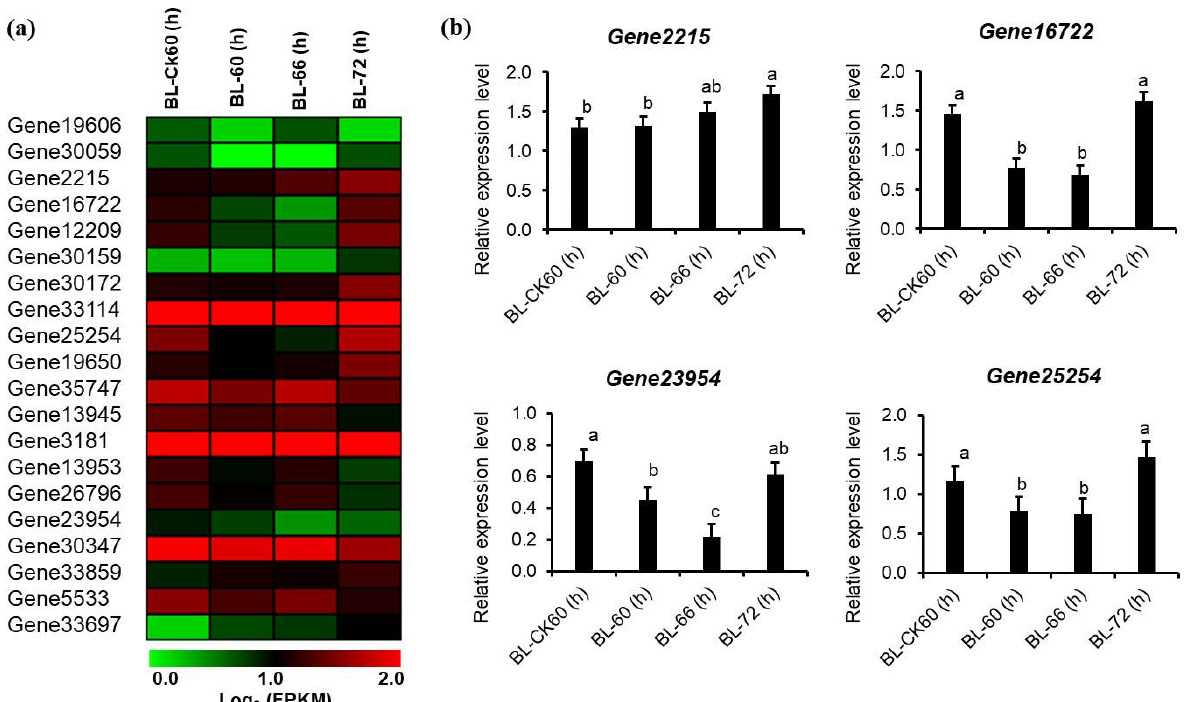
Figure 9. Expression profiling of carbon metabolism DEGs in the hypocotyl of Robinia pseudoacacia -148 during adventitious root formation; ( a ) Heat map illustration of log2 (FPKM) values for annotated genes during carbon metabolism pathway; ( b ) Relative expression of carbon metabolism pathway genes as determined by RT-qPCR. The data presented are the average of three technical replicates. Different letters indicate significant difference by least significant difference (LSD) test ( p ≤ 0.05). Bar = SD.